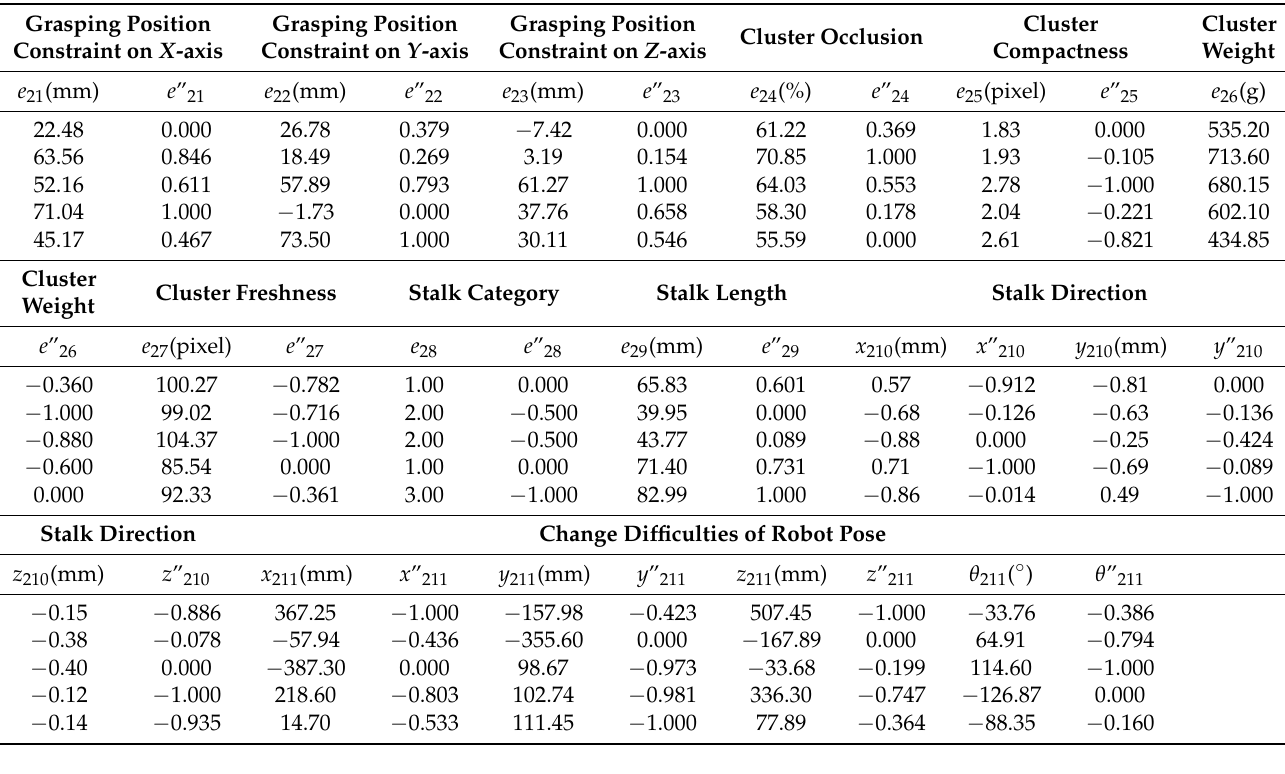
Table 4. Experimental data with main differences of change difficulties of robot